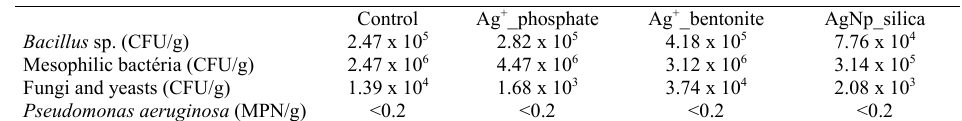
Table 4. Soil microbiota after harvest Control